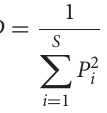
FIGURE 1 | A map of glaciers studied in Svalbard showing the sampling sites (a) and photographs of the glaciers. (b) Austre Brøggerbreen, (c) Midtre Lovénbreen, (d)